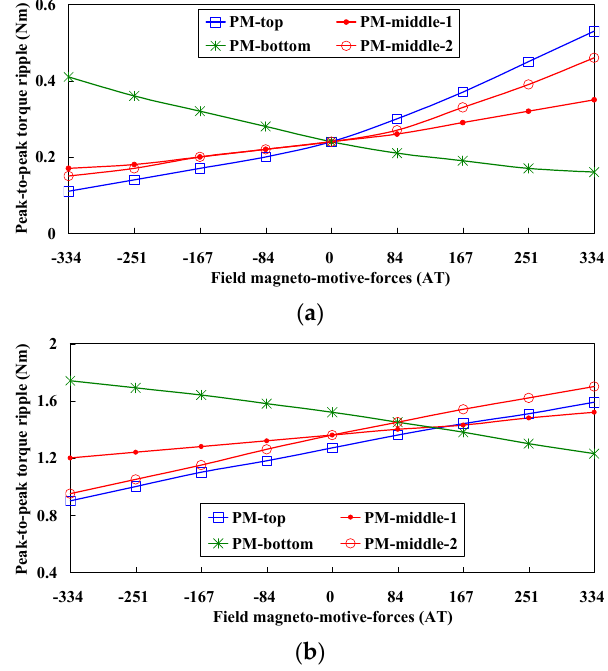
Figure 8. Variation of torque ripple values by different field currents. ( a ) Employing ferrite; ( b ) Employing NdFeB.